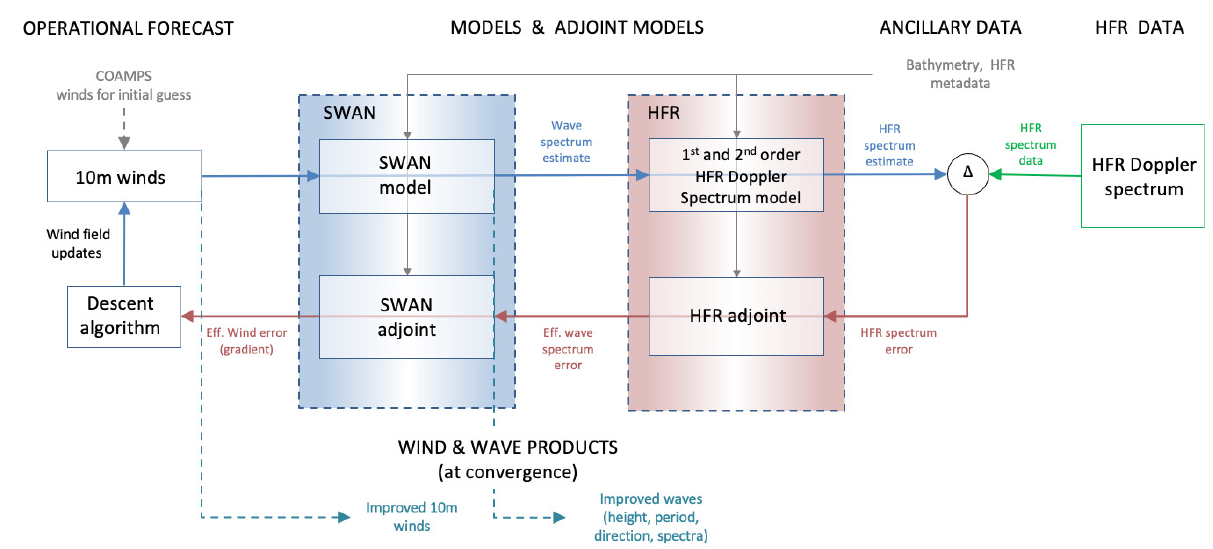
Figure 1. Algorithm flow chart. The algorithm makes use of operation forecast data (as a first guess for winds), models and adjoint models, ancillary data (such as bathymetry), and HF radar Doppler data. The algorithm outputs are wind and wave products, improved wave spectra and improved estimates of the wind